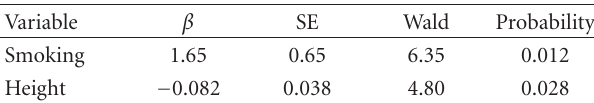
Table 2: Cox hazard stepwise regression analysis for all mortality